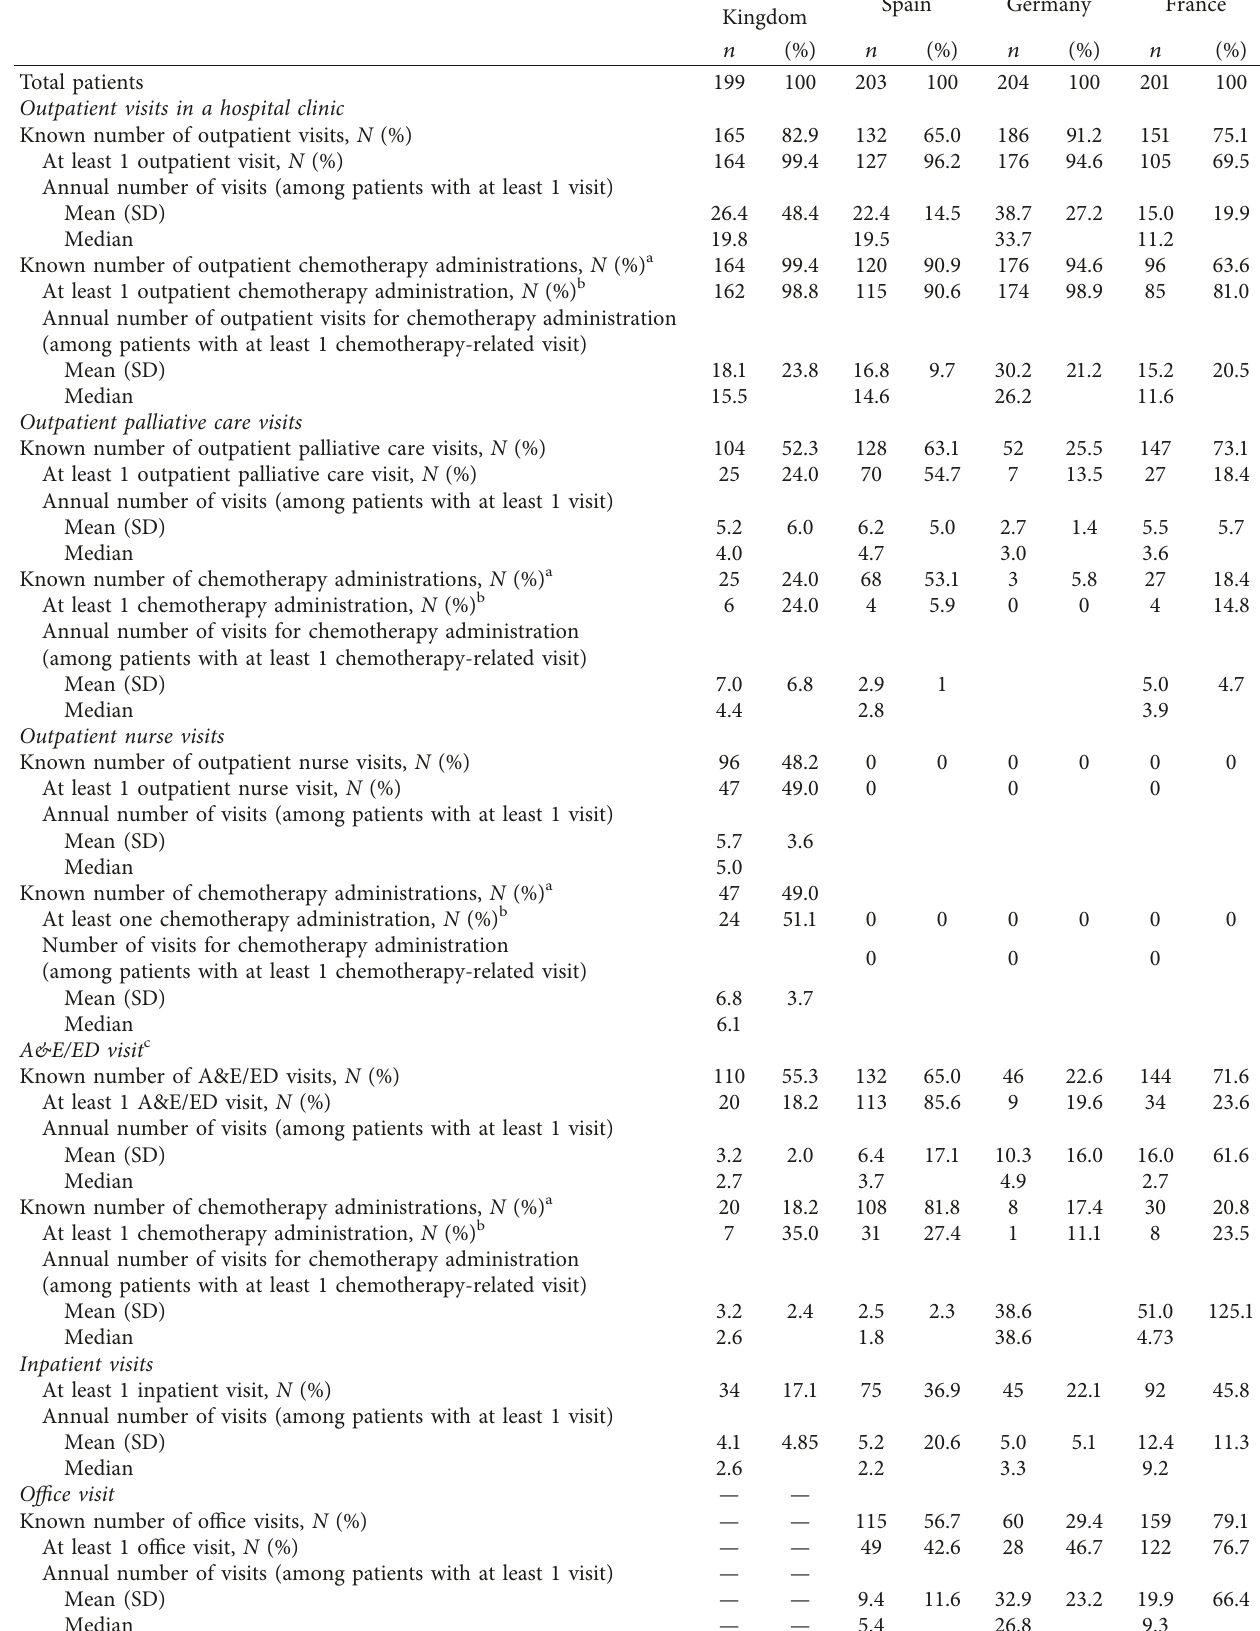
Table 2: Health care resource utilization from diagnosis of advanced soft tissue sarcoma, by